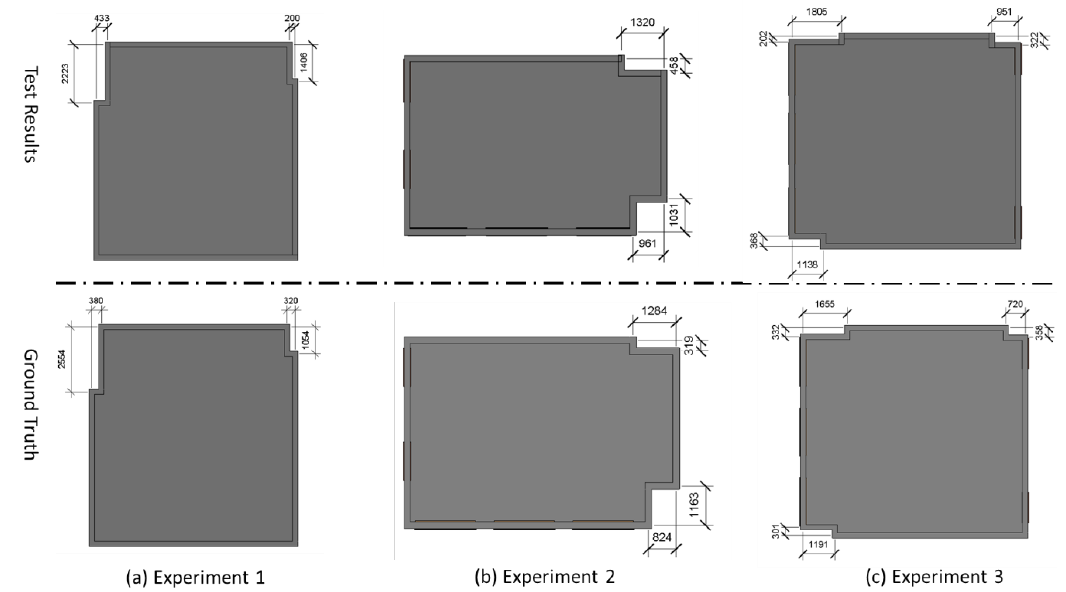
Figure 17. The compare between measurement length of the “narrow” walls and the actual values collected by range finder.